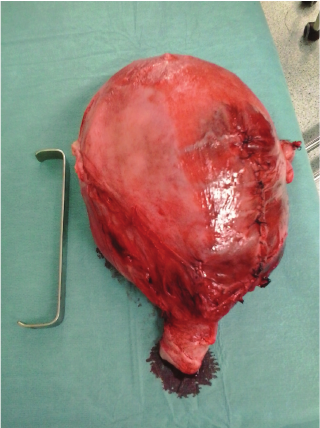
Figure 2: Uterus after postcesarean hysterectomy (median suture of hysterorrhaphy is